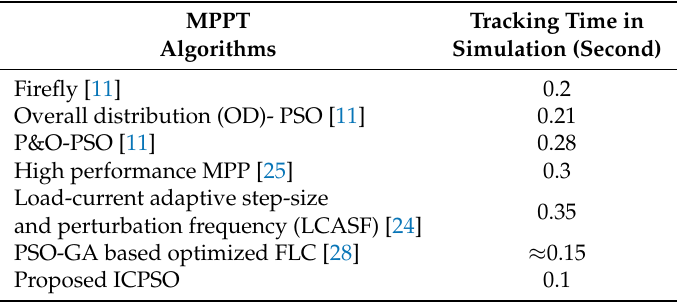
Table 3. Comparative performance analysis of tracking time of